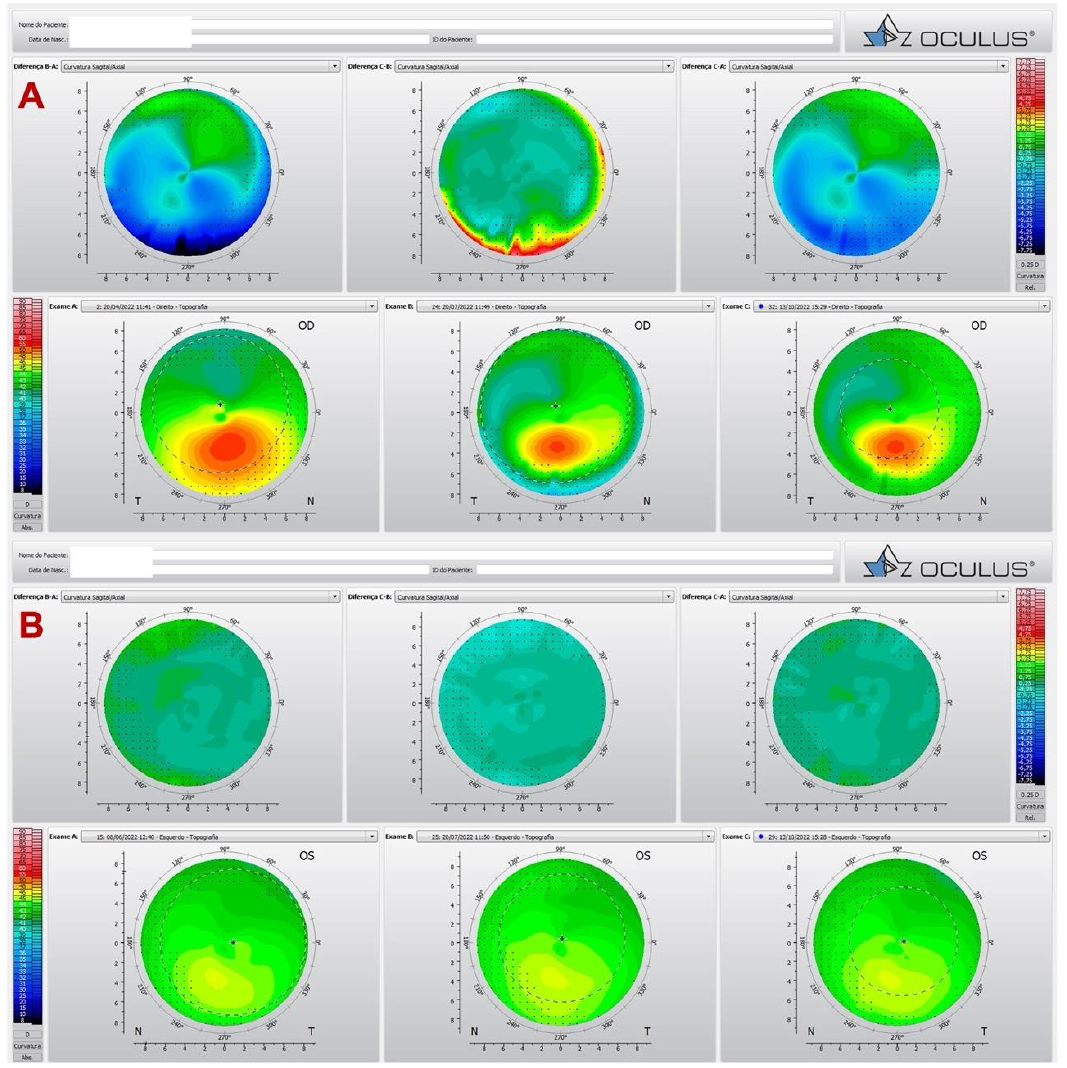
Figure 4. Pentacam differential map showing in OD ( A ) the topography before and after the ICRS, and in OS ( B ) topometric and tomographic stability along the time.